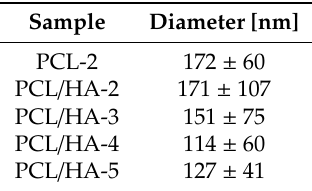
Table 3. Diameter of the electrospun fibers.